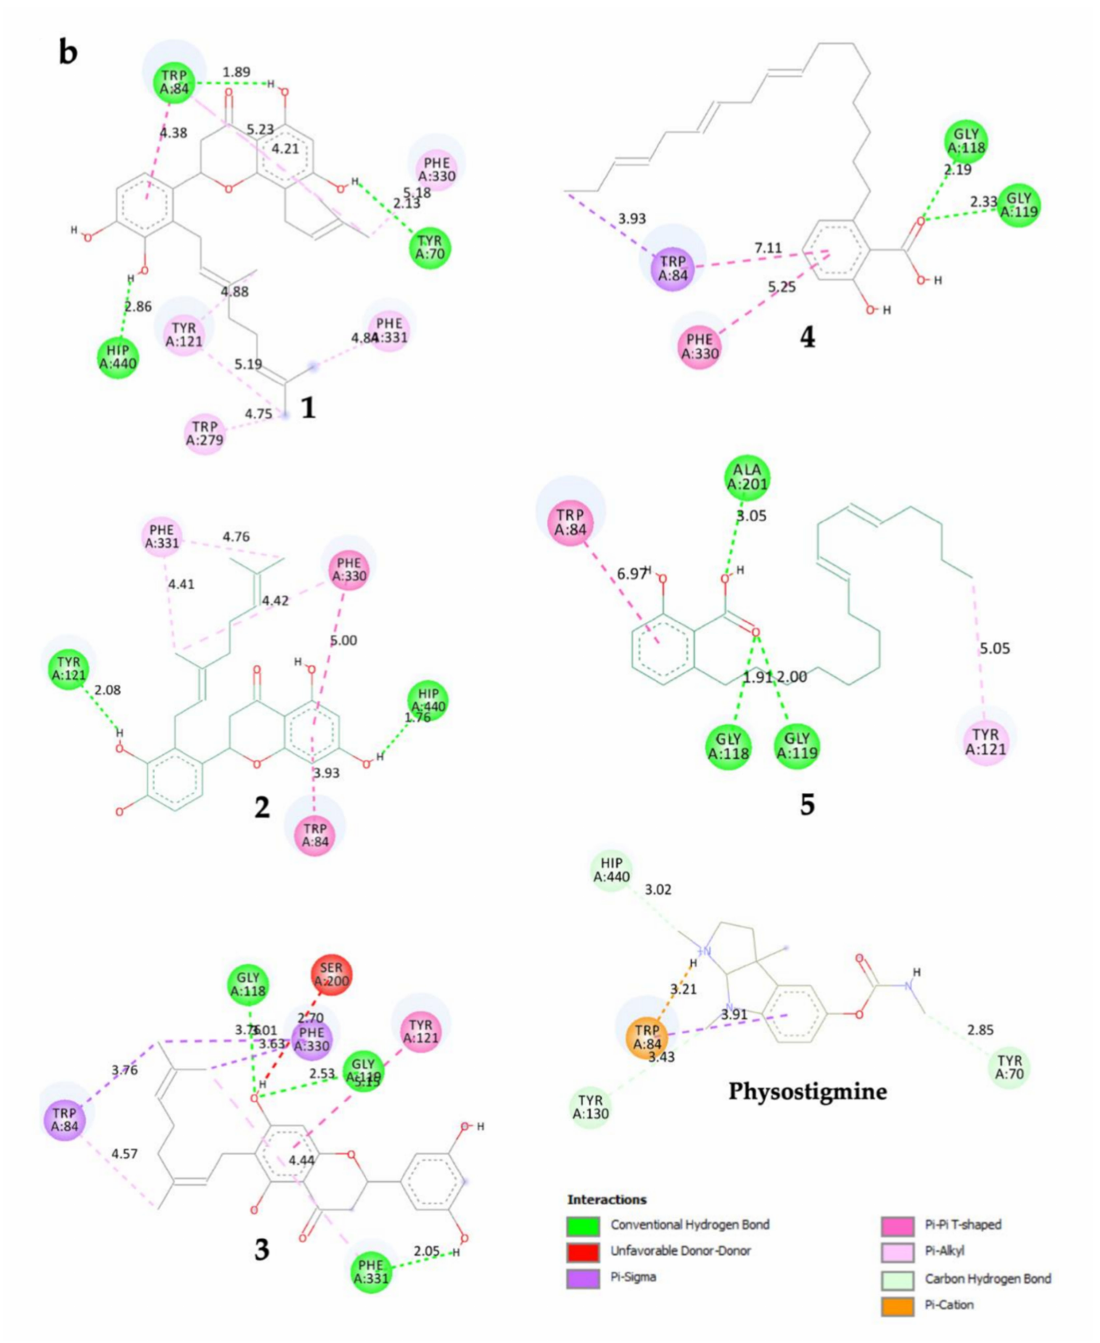
Figure 2. ( a ) 3D representation of molecular interactions between 1 and 5 and TcAChE residues (PDB ID: 1W6R) ( b ) 2D representation of molecular interactions between 1 and 5 and TcAChE